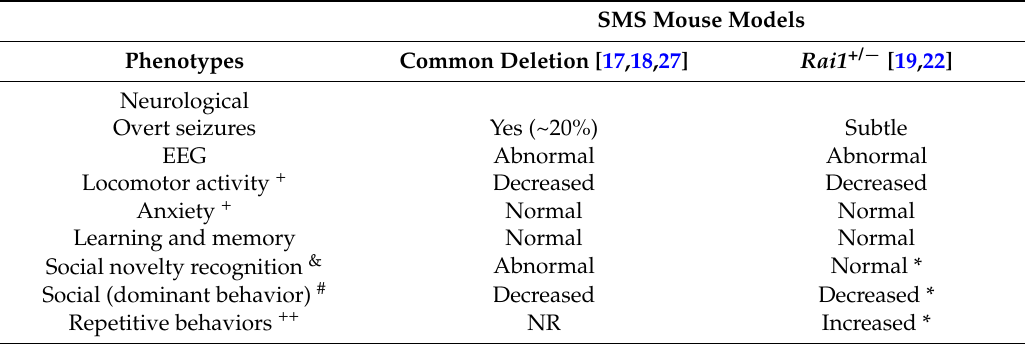
Table 2. Comparison of neurological phenotypes in mice with the syntenic common 17p11.2 deletion and those with a Rai1